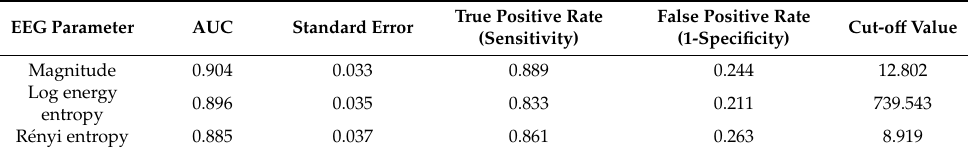
Abbreviation AUC: Area under the